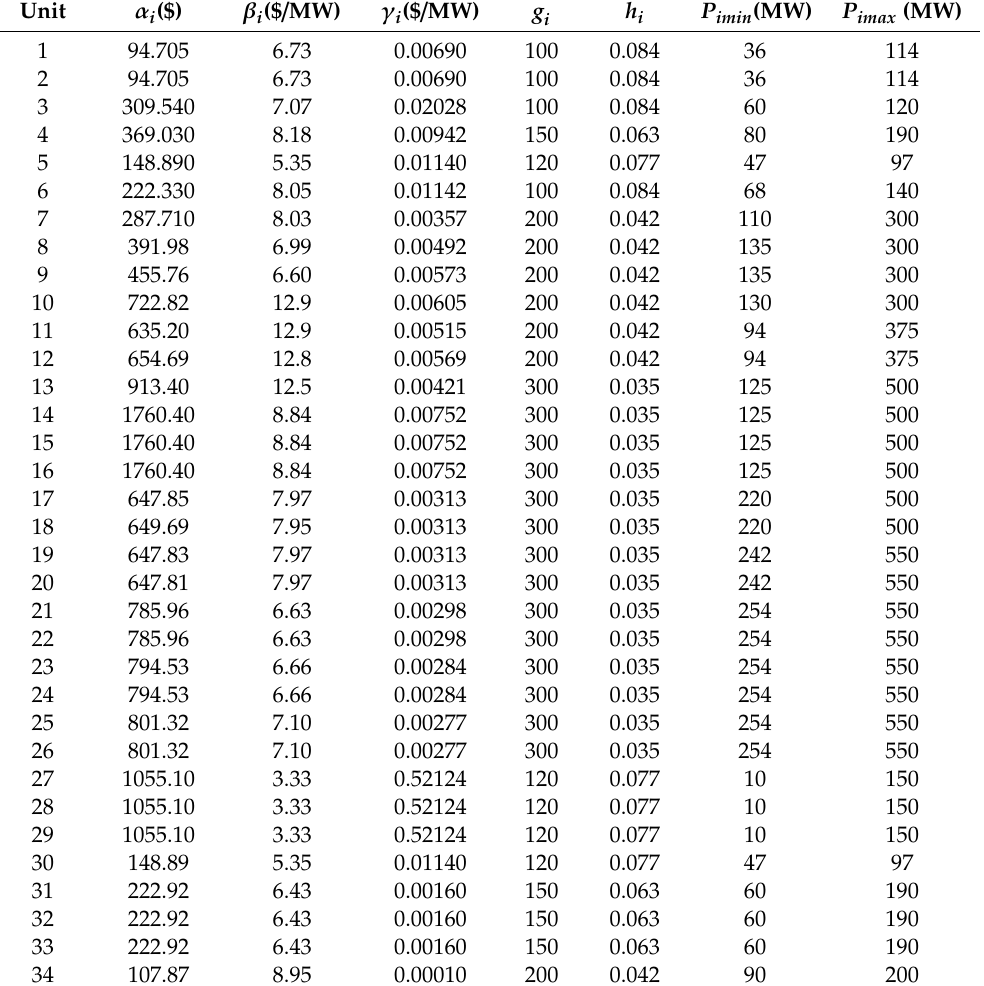
Table 11. Generator unit capacity and coe ffi cients on fourth case